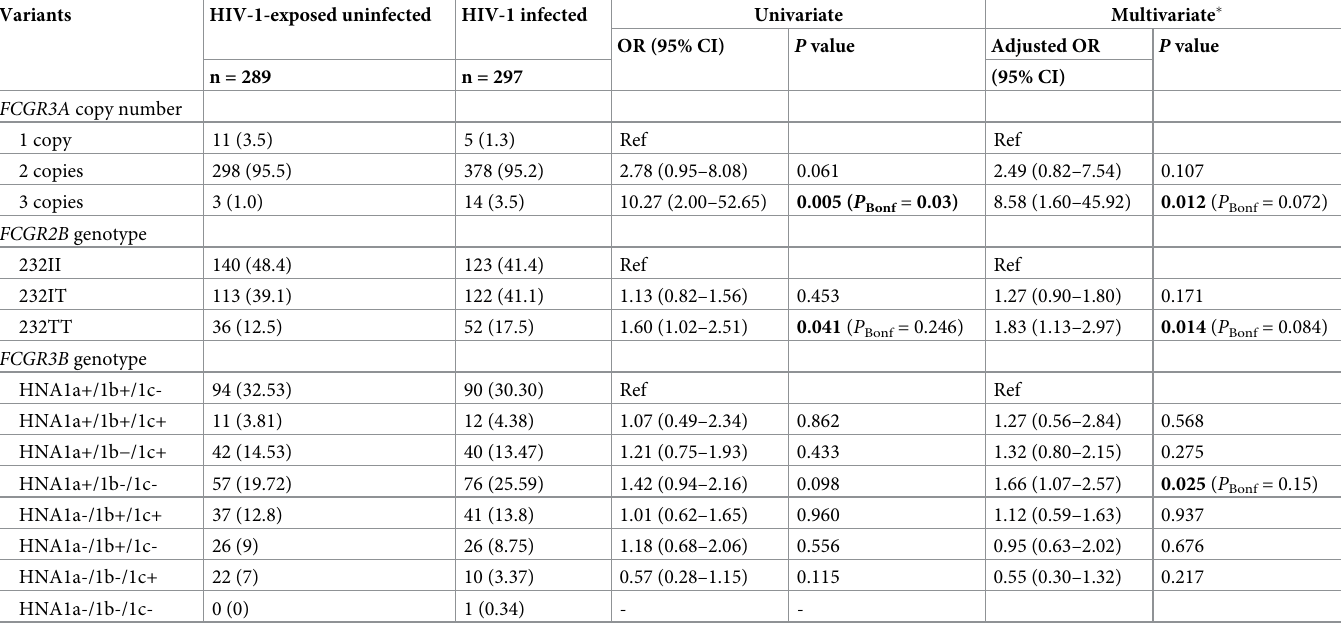
Table 4. Associations of FCGR variants with perinatal HIV-1 acquisition in non-breastfed children after adjusting for birthweight.